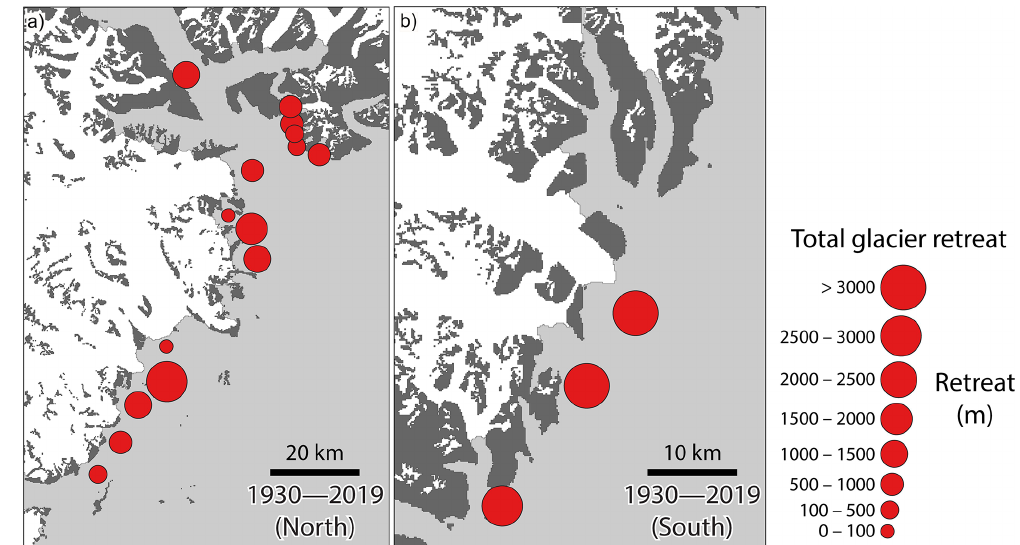
Figure 3. Graphical representation of overall change in glacier frontal position rate (1930–2019) in both the northern (a) and southern (b) study areas in East Greenland (see Fig. 1). Red circles represent total retreat over the period between our earliest (BAARE) and latest (Landsat) data, and are sized proportionally according to the magnitude of retreat. See Figs. 4 and 5 for higher temporal resolution changes derived from our imagery. Table 2. Raw advance (positive)/retreat (negative) for all time steps for all individual glaciers as numbered in Fig. 1. All quantities are in metres per year. Missing values indicate that imagery of the glacier is not present in one of the two datasets used for that time step. Estimated errors for glacier change for each time step is: 1930–1966: ± 0 . 7m per year, 1966–1985: ± 1 . 6m per year; 1985–1995: ± 3 . 9m per